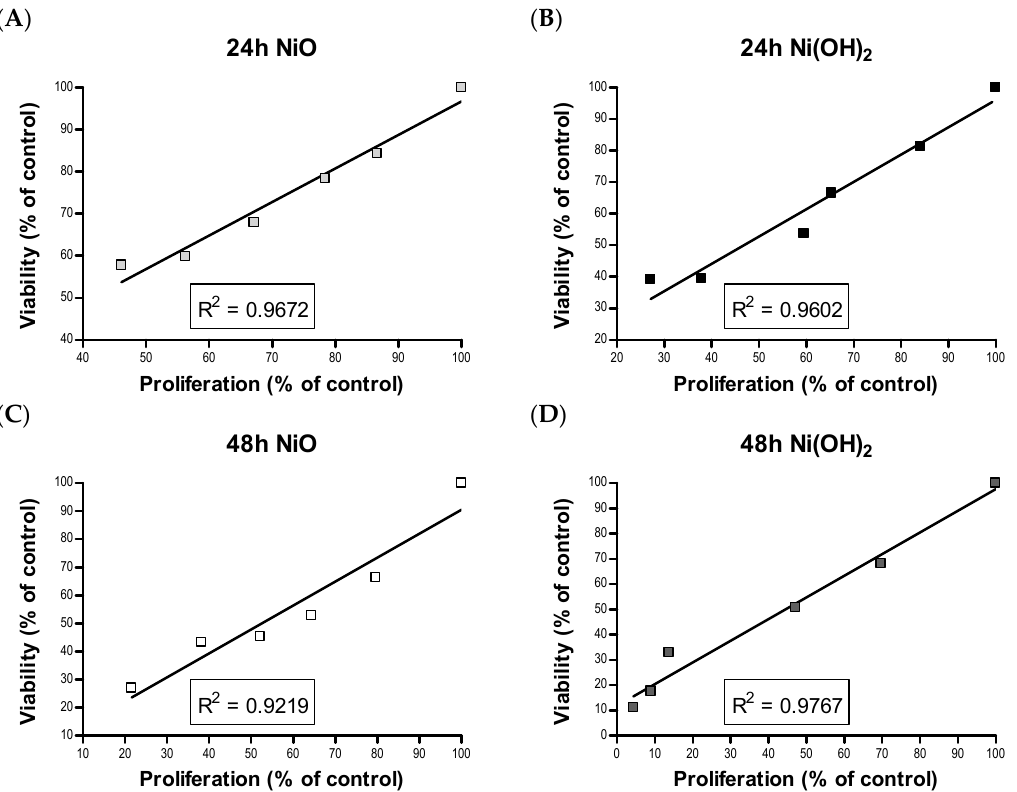
Figure 12. Linear correlation between viability and proliferation rankings for ( A ) 24 h NiO, ( B ) 24 h Ni(OH) 2 , ( C ) 48 h NiO, and ( D ) 48 h Ni(OH) 2 .